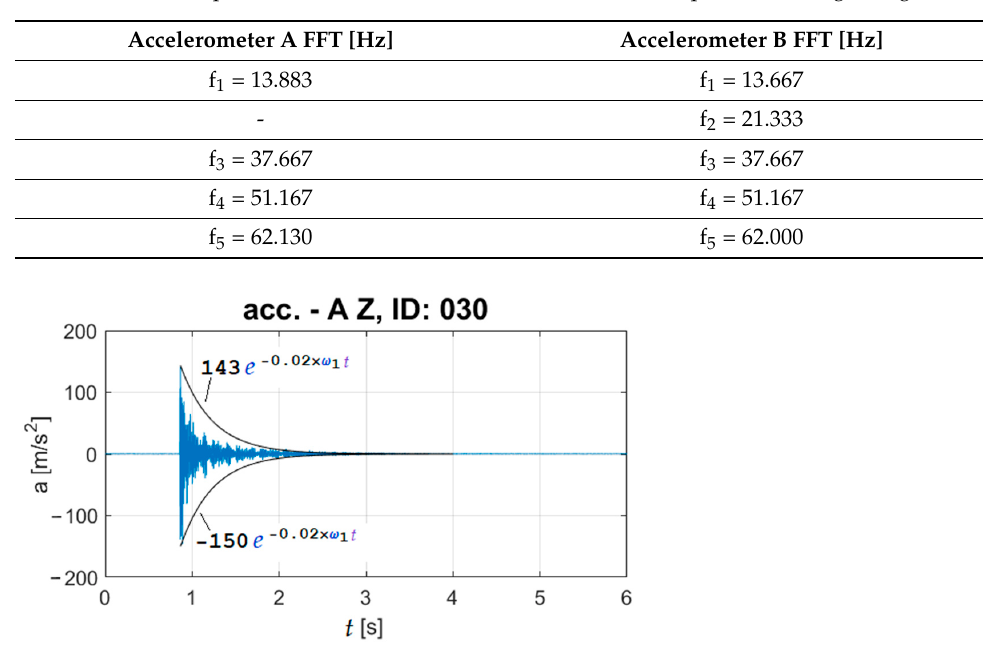
Figure 13. The Fast Fourier Transformation (FFT) of the frequency response function of all measure- ment with the two accelerometers (A and B) in the z-direction. Table 3. The first few eigenfrequencies of the system. Apparently the second frequency in accelerometer A was not excited, a possible reason that a node was hit. The other frequencies are in good agreement.